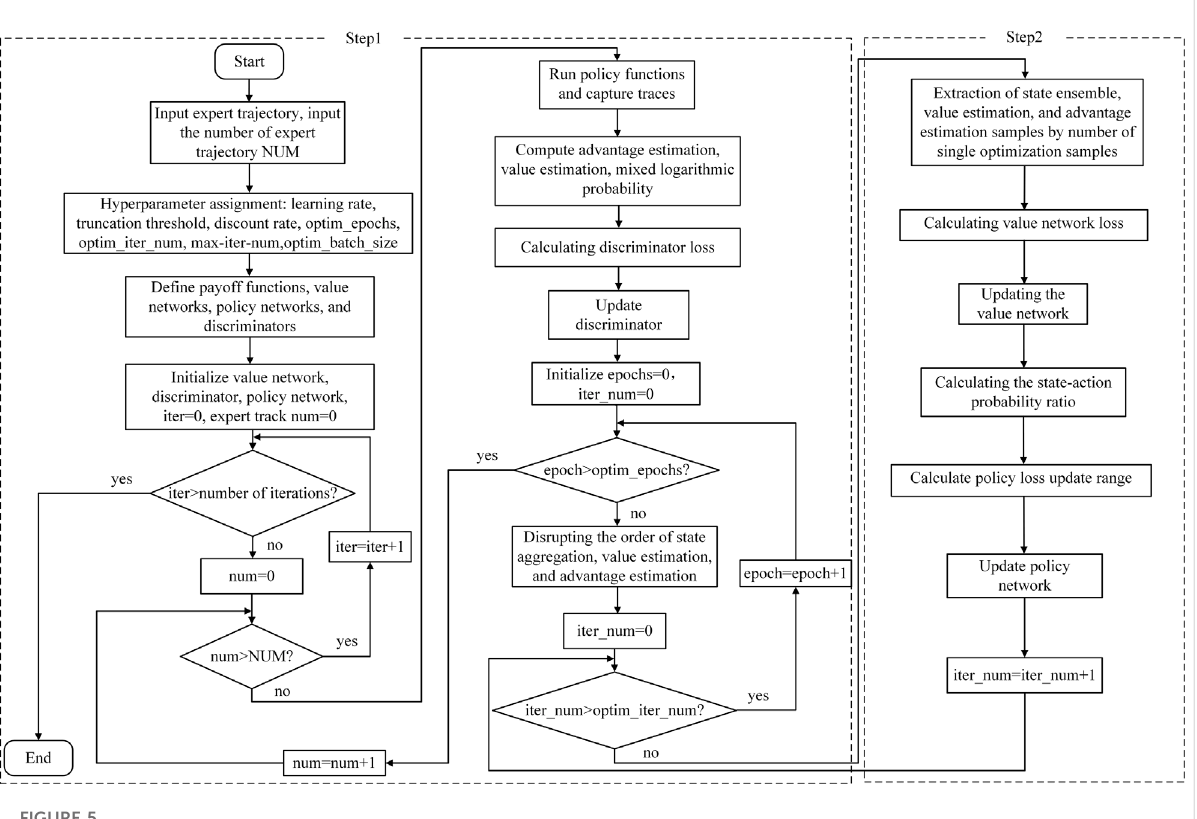
FIGURE 5 Flow chart of strategy learning based on the PPO algorithm.